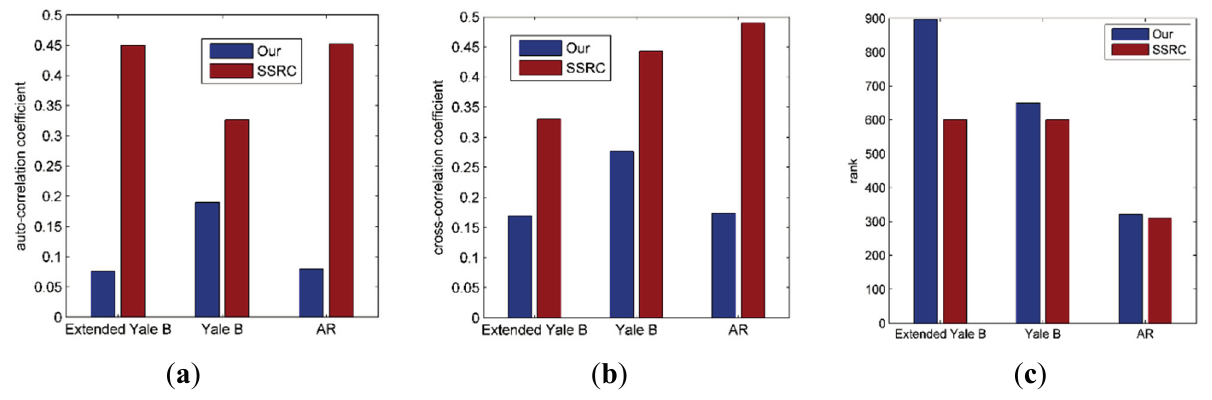
Figure 3. The comparative results of low-rank minimization optimization under difference face datasets. ( a ) auto-correlation coefficient of facial variation bases; ( b ) cross-correlation coefficient between facial variation bases and prototype base; ( c ) the rank of facial variation